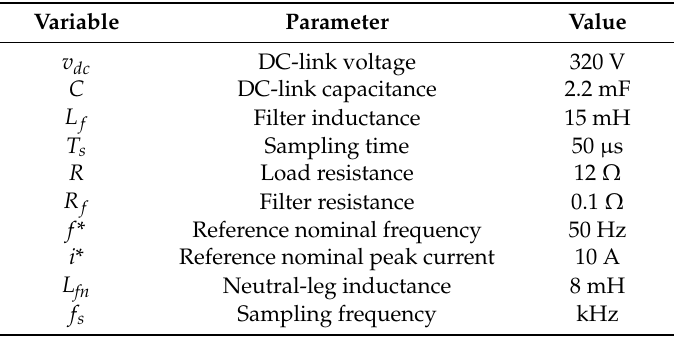
Table 4. Parameters of the experimental